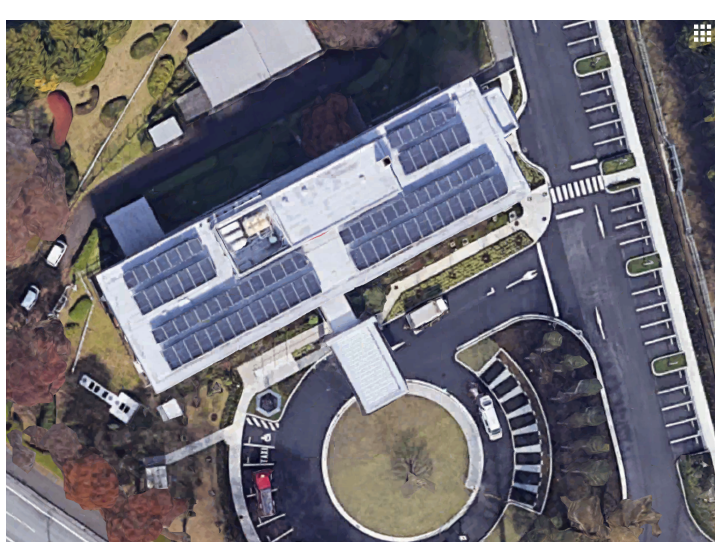
Figure 3. Hardware installed at participant homes.